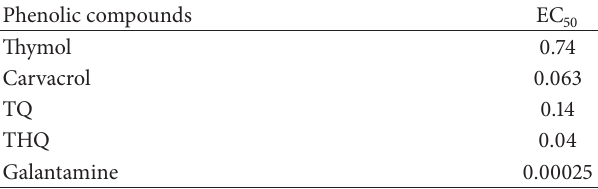
Table 1: The AChE inhibitory effects of some phenolic